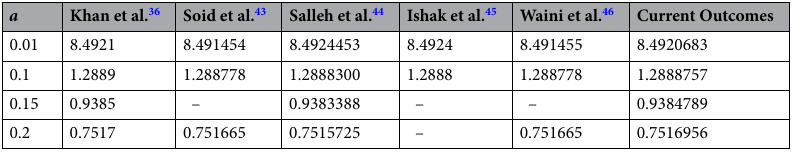
1 2 C f for several values of needle size a when Pr = 1 and the rest of all comprising Table 2. Comparison of ( Re x ) parameters are